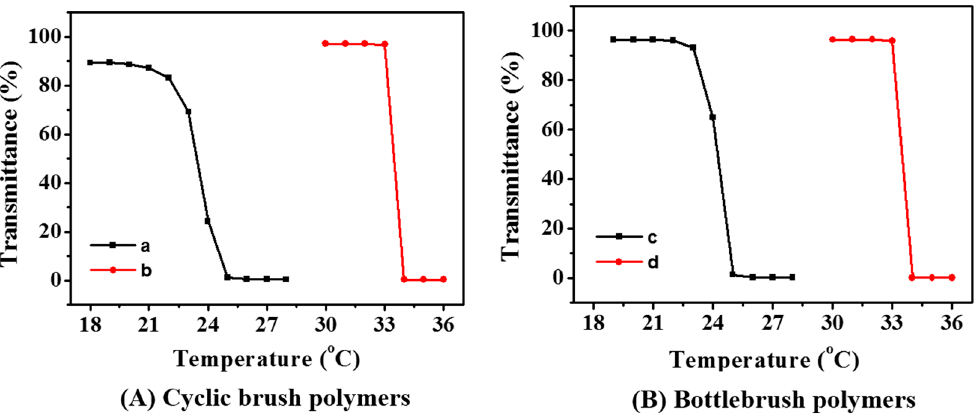
Figure 6. Temperature-dependent optical transmittance at 500 nm recorded for cb -P(HEMA- g - PNIPAAm 42 ) 50 (a); cb -P(HEMA- g -PNIPAAm 182 ) 50 (b); bb -P(HEMA- g -PNIPAAm 42 ) 50 (c) and bb - P(HEMA- g -PNIPAAm 182 ) 50 (d) (1.0 mg/mL, PBS, pH 7.4, 10